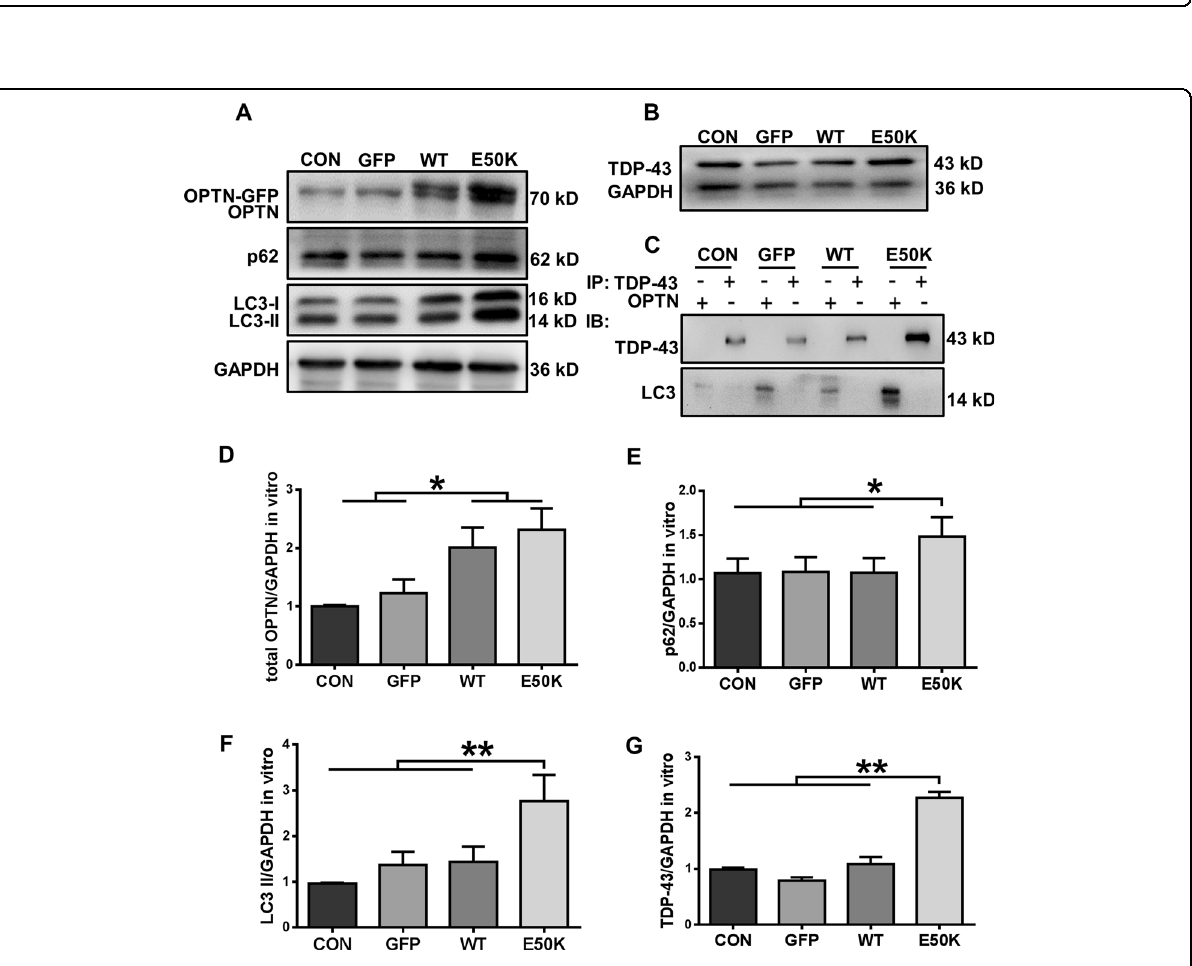
Fig. 6 Overexpression of E50K optineurin disrupts autophagy and causes the degradation of TDP-43 in vitro. A , B OPTN, p62/SQSTM1 and LC3 protein expression and TDP-43 protein expression in the cytoplasm were analysed in blank control, AAV-GFP-, GFP-WT- and GFP-E50K- transfected R28 cells by western blotting. C Western blot analysis of immunoprecipitation assays of TDP-43 or OPTN in R28 cells. D – F Quanti fi cation of OPTN, p62/SQSTM1, LC3 and TDP-43 protein expression levels. n = 3. * P < 0.05; ** P <